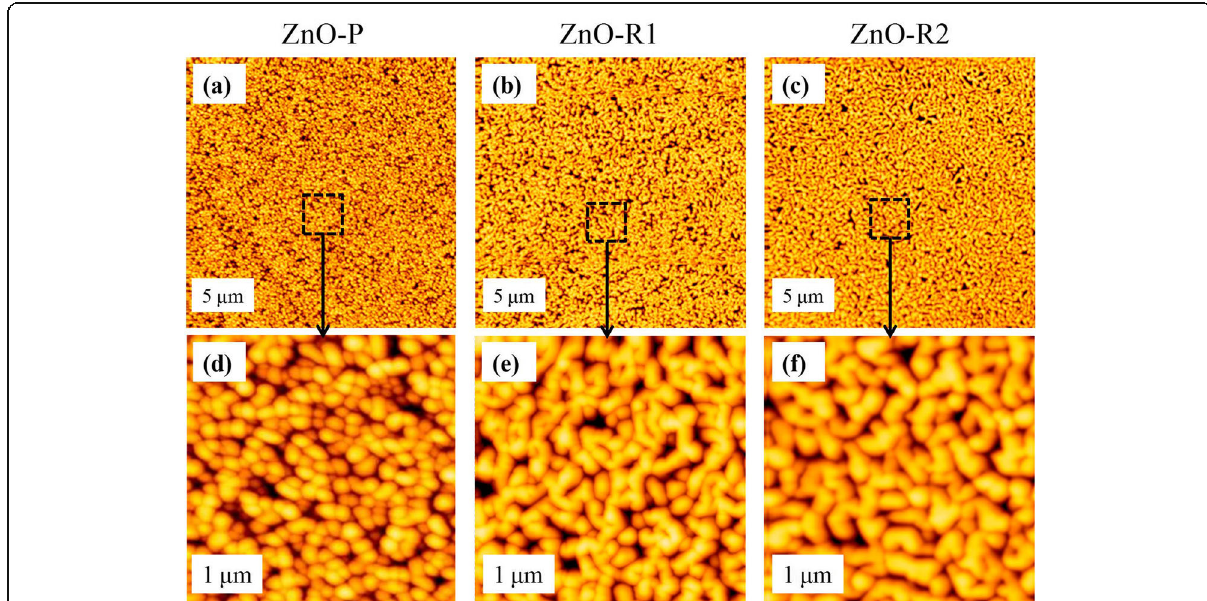
Fig. 1 AFM results. a – c AFM images of the ZnO film surface morphologies (5 μ m). d – f Magnified images of the square areas (marked by dashed black lines) in a – c